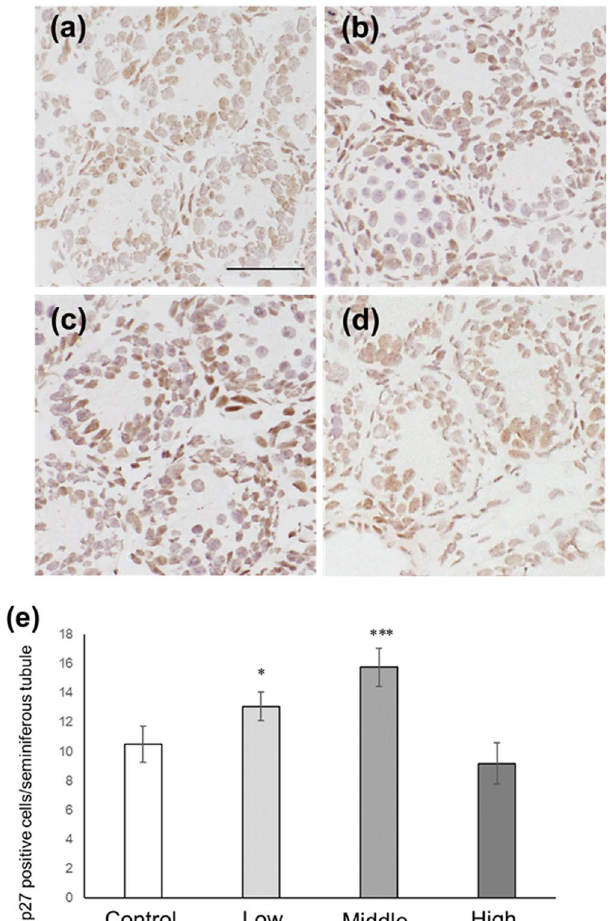
Figure 7. Number of p27-positive Sertoli cells in CORT-administered mice on PND 10. Representative micrographs of Sertoli cells immunostained with anti-p27 antibody in the testes from control ( a ), low-dosed ( b ), middle-dosed ( c ), and high-dosed-CORT mice ( d ) on PND 10. The scale bar is 50 µm. P27-positive cells per seminiferous tubule among the control and CORT mice ( e ). Values are expressed as the mean ± S.E.M of data from 10 animals per group (10 seminiferous tubules per animal). *p < 0.05 and ***p < 0.001 compared to the